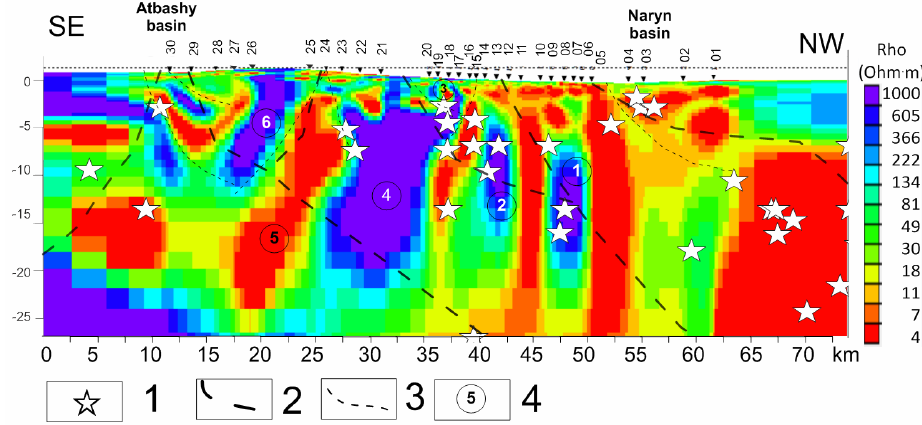
Fig. 4. 2D-inversion model for the "Karabuk" profile (75˚), fault structures are shown in the